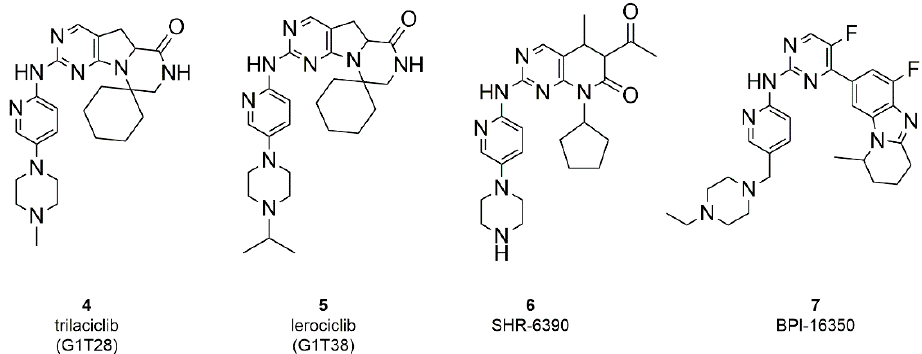
Figure 3. Chemical structure of ATP-competitive CDK 4/6 selective inhibitors in clinical trials.